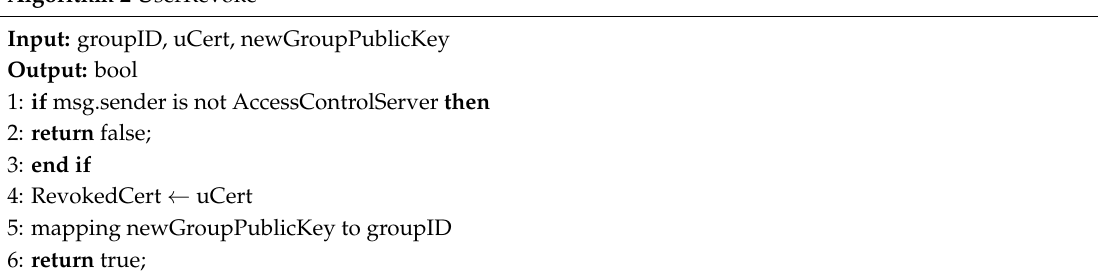
Algorithm 2 UserRevoke